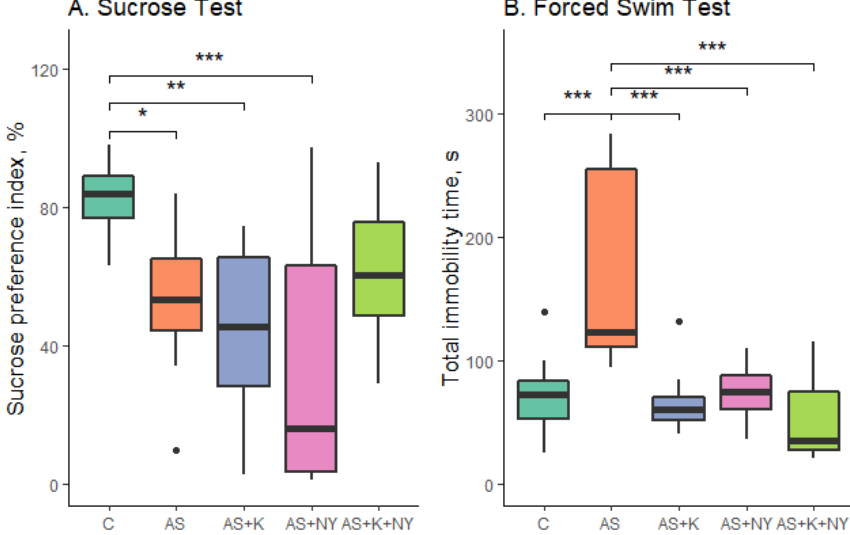
Figure 2. The results of the experiment involving acute stress. C—control rats; AS—rats exposed to acute stress; AS + K—rats exposed to acute stress and administrated with clomipramine; AS + NY—rats exposed to acute stress and administrated with neuropeptide Y; AS + K + NY—rats exposed to acute stress and administrated with clomipramine and neuropeptide Y; *— p < 0.05; **— p < 0.01; ***— p < 0.001.